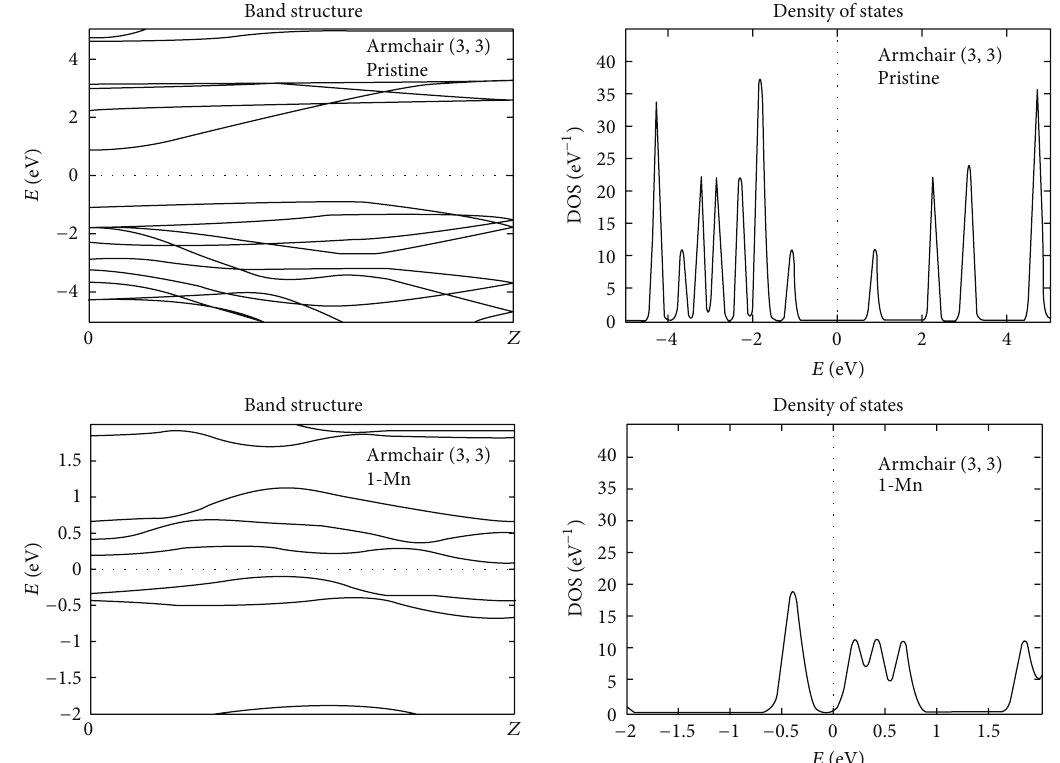
Figure 5: The band structure and density of states profile of pristine and Mn doped armchair (3, 3) GaN nanotubes.